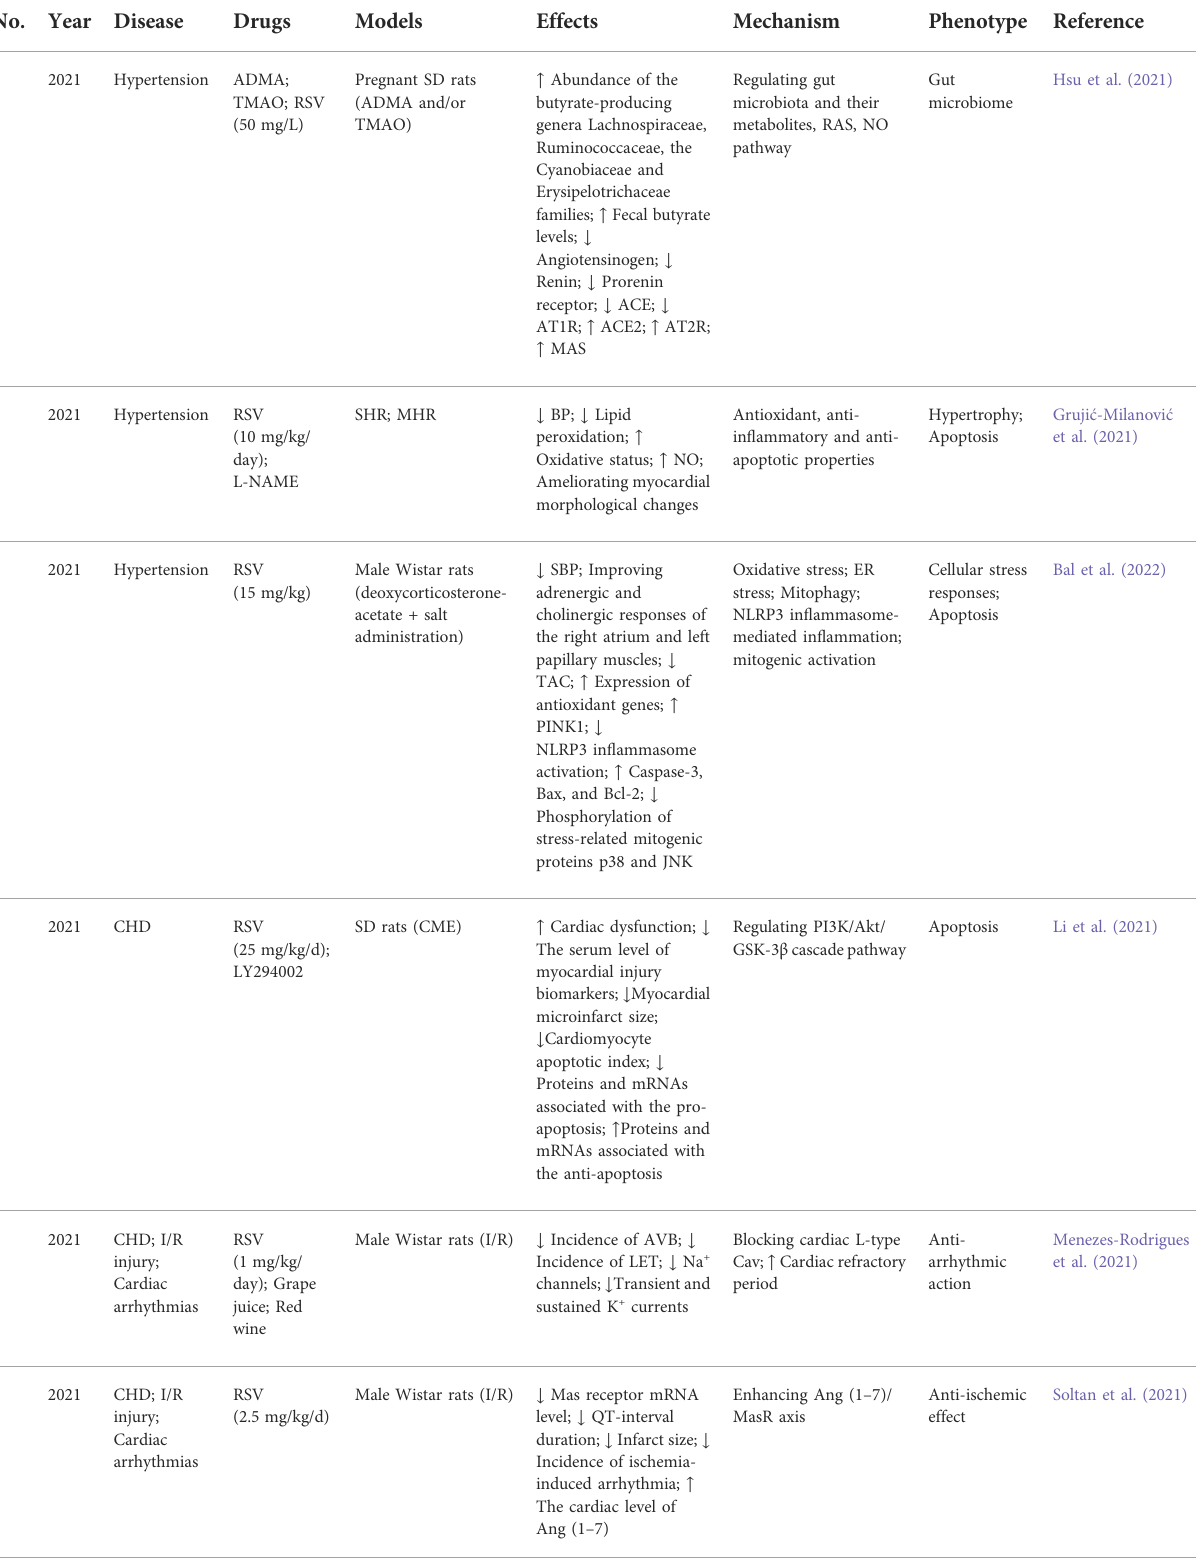
TABLE 2 Molecular mechanism of resveratrol in different cardiac remodeling phenotypes of independent cardiovascular disease in recent 1